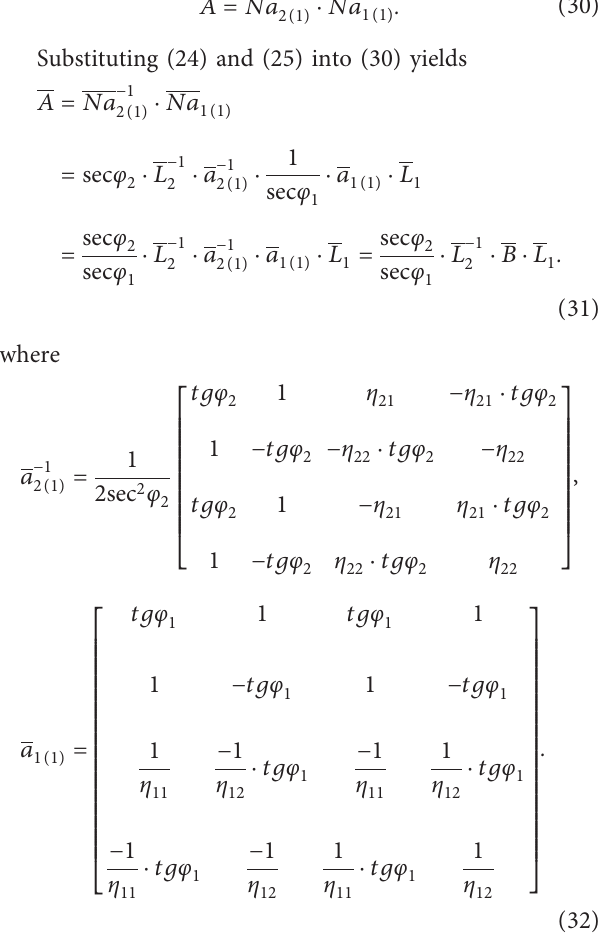
Figure 2: Schematic diagram demonstrates the measurement coordinate ({ x , y , z }) and media coordinate ({ x ′ , y ′ , z ′ }). They own a common z / z ’ axis and rotate with azimuth angle φ . The red ellipse is the indicatrix ellipse, which indicates the principal axis direction of the permittivity tensor. Here, we suppose that the semimajor axis denotes x ′